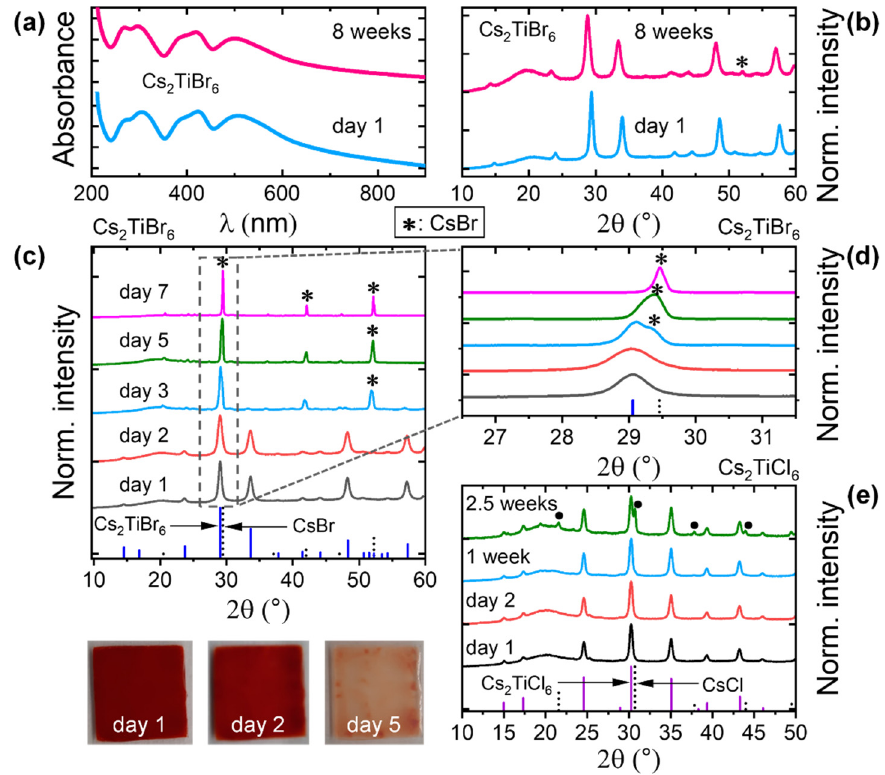
Figure 3. Environmental stability of the NCs. ( a ) Absorption spectra and ( b ) XRD patterns of as- casted Cs 2 TiBr 6 NC (synthesized at 185 °C without OlAm) films from a hexane suspension, which was kept in ambient conditions up to 8 weeks (~40% RH and ~25 °C). The data were collected at the beginning (day 1) and at the end of the storage time (8 weeks). The photographs are of the Cs 2 TiBr 6 NC film on day 1, day 2, and day 5 of its storage in ambient conditions. ( c ) The evolution of XRD pattern of Cs 2 TiBr 6 NC film as a function of time in ambient conditions. The reference XRD patterns of Cs 2 TiBr 6 (Rietveld refinement data) and CsBr (ICSD code: 01-073-0391) are shown in the same graph. ( d ) A portion of the panel ( c ) is highlighted. ( e ) The evolution of XRD pattern of Cs 2 TiCl 6 NC film as a function of time in ambient conditions. The reference XRD patterns of Cs 2 TiCl 6 (Rietveld refinement data) and CsCl (ICSD code: 01-073-0390) are shown in the same graph. The symbols * and • represent the reflections corresponding to CsBr and CsCl, respectively. The color change on day 5 indicates the partial loss of TiBr 4 from the NC film.